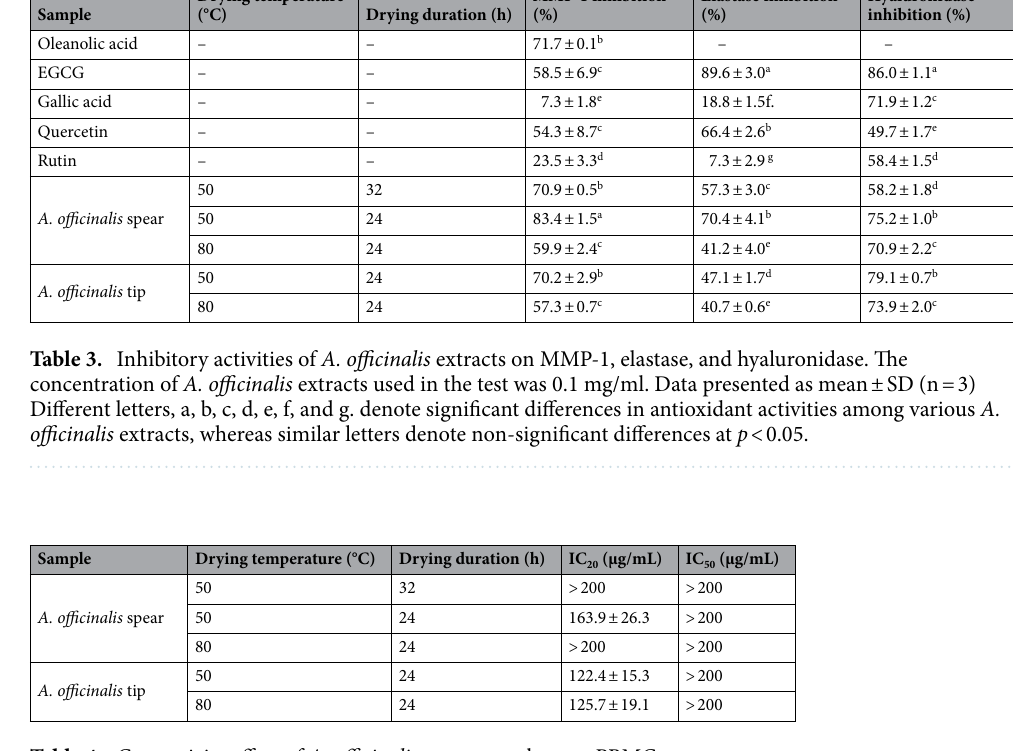
Table 4. Cytotoxicity effect of A. officinalis extracts on human PBMCs.